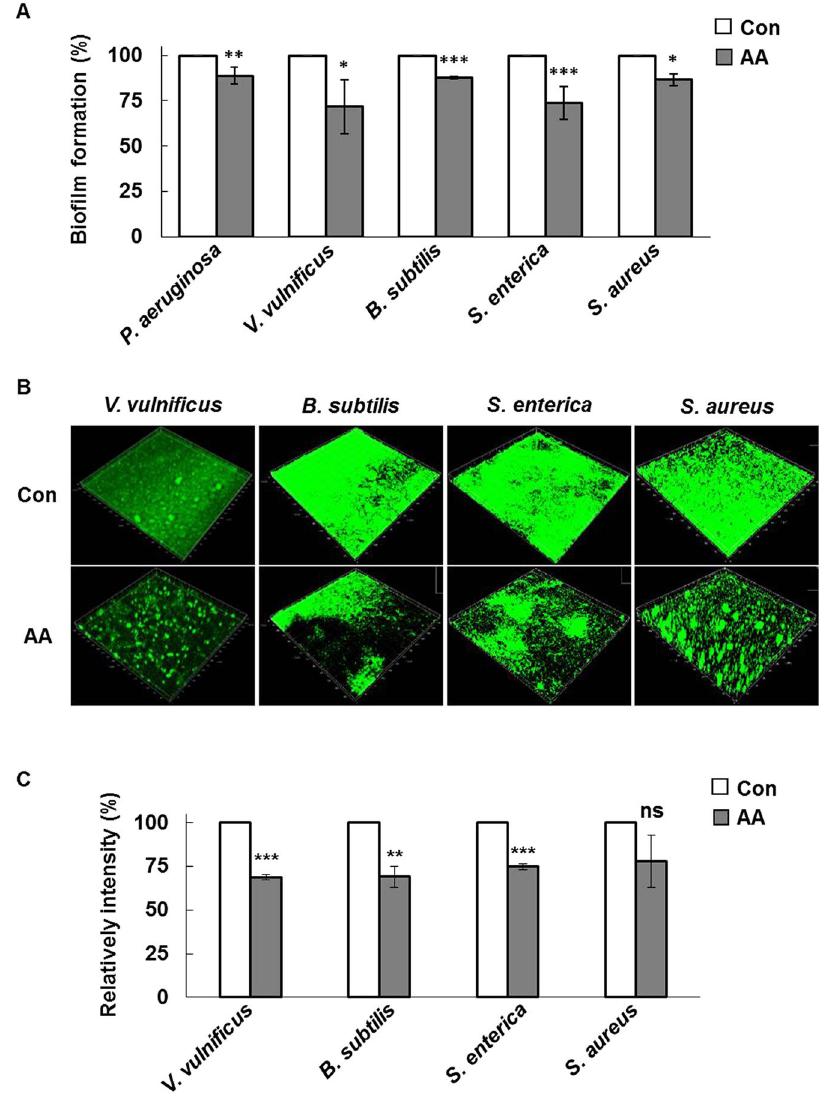
Figure 5. Detachment of preformed biofilms by anthranilate ( A ), bacterial biofilms were formed in the absence of anthranilate for 12 hours in the static biofilm system and then 0.1 mM anthranilate was added. After 12 hours of incubation, residual biofilms were quantified by crystal violet staining. ( B ) Biofilms were formed in the absence of anthranilate for 2–3 days in the flow cell system, and then treated with 0.1 mM anthranilate for 24 hours. A preformed biofilm was incubated without anthranilate under the same conditions as a control. All biofilms were imaged by CLSM ( B ) and fluorescence intensities were quantified ( C ). Con, control; AA, 0.1 mM anthranilate. * p < 0.05; ** p < 0.01; *** p < 0.005; ns, no significant difference ( p >